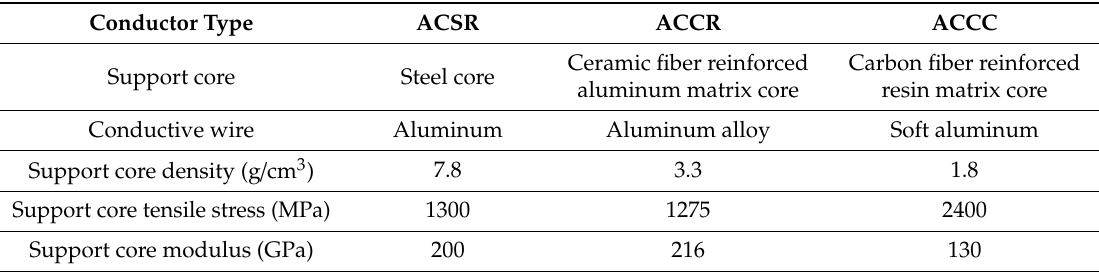
Table 1. Structures and basic mechanical properties of aluminum conductor steel reinforced (ACSR), (Aluminum Conductor ceramic fiber reinforced aluminum matrix Composite core Reinforced (ACCR), and Aluminum Conductor Composite Core (ACCC)